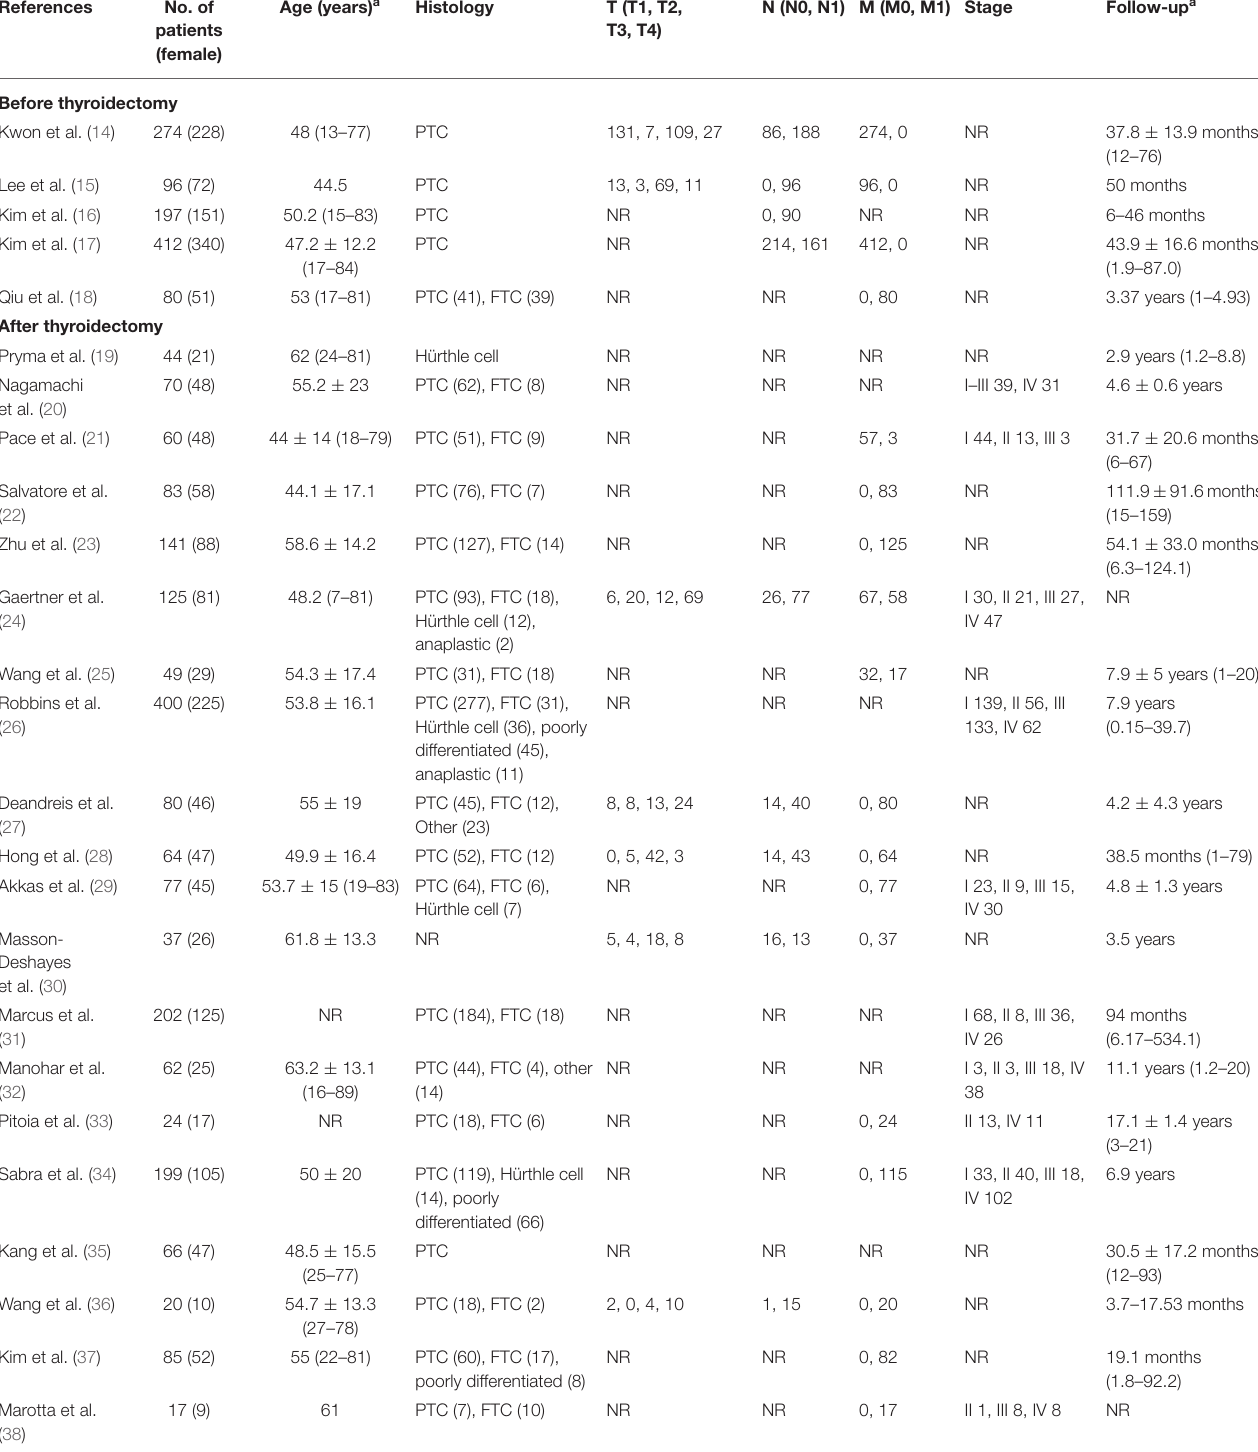
TABLE 1 | Summary of characteristics of the included